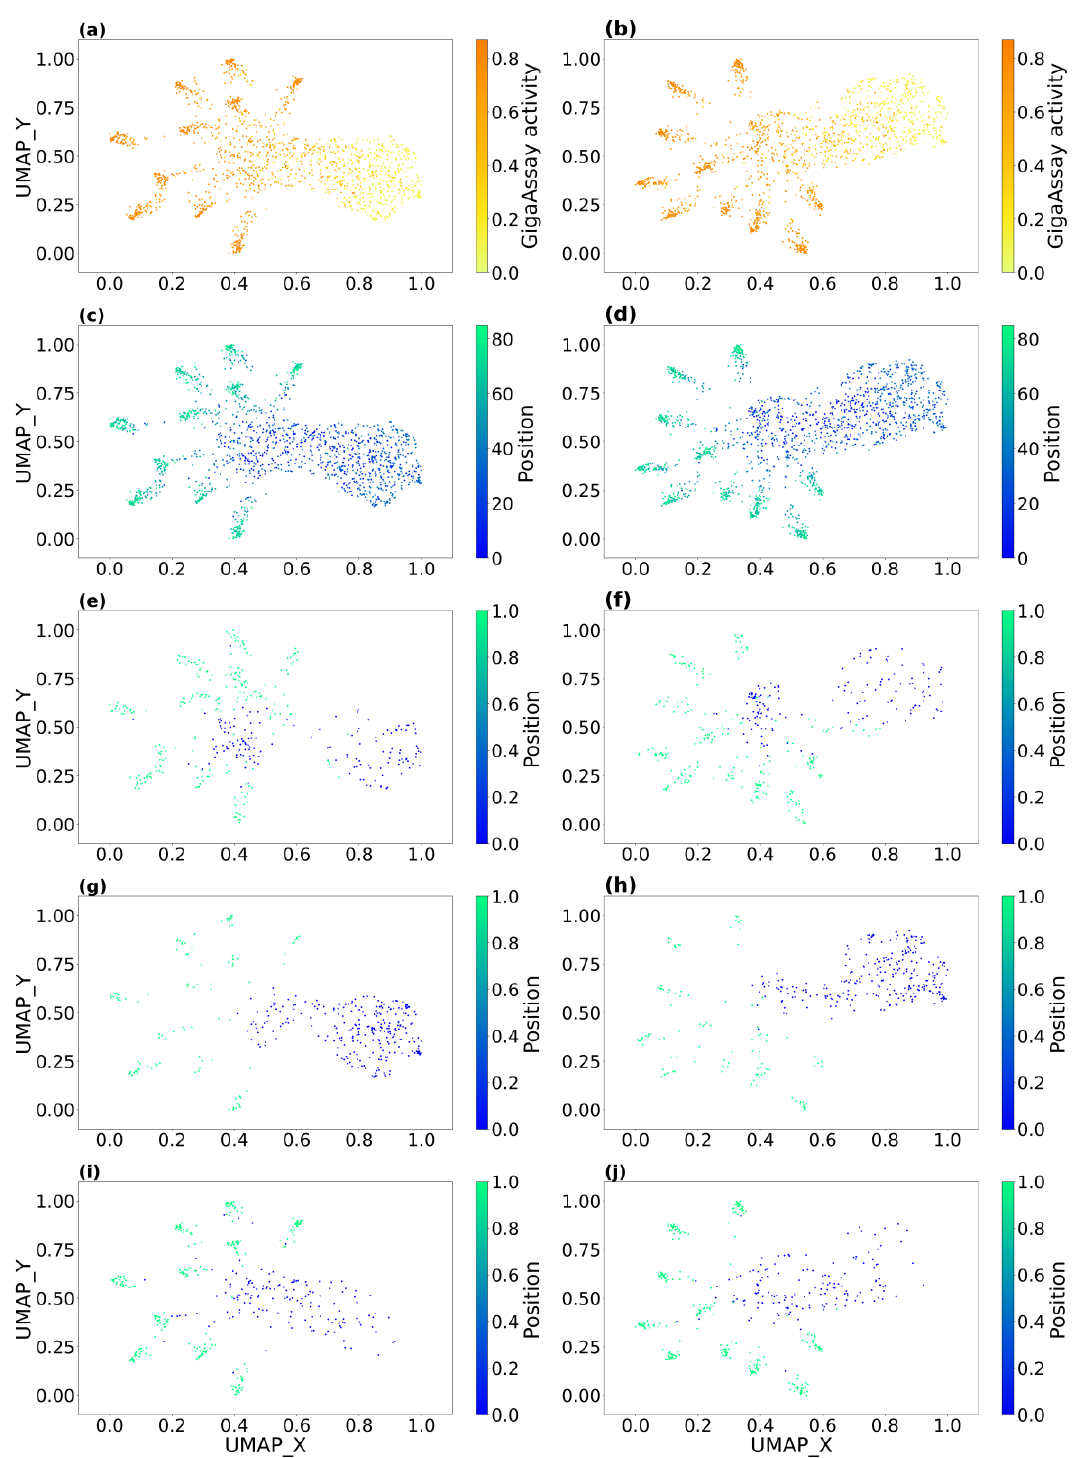
Figure 5. Visualization of the Rep2Mut final vectors after dimensionality reduction with UMAP: ( a , c , e , g , i ) with position vector; ( b , d , f , h , j ) without position vector; ( a , b ) colored by GigaAssay activities; ( c – j ):colored by positions; ( e , f ) positively charged amino acids (Arg, His, and Lys); ( g , h ) special cases of amino acids (Cys, Gly, and Pro); ( i , j ) polar uncharged amino acid (Ser, Thr, Asn, and Gln). In ( e – j ), 0: (blue) positions of variants lower than 45; 1: (green) positions of variants larger than 45, and this is why ( e – j ) have different color ranges from ( c , d ).